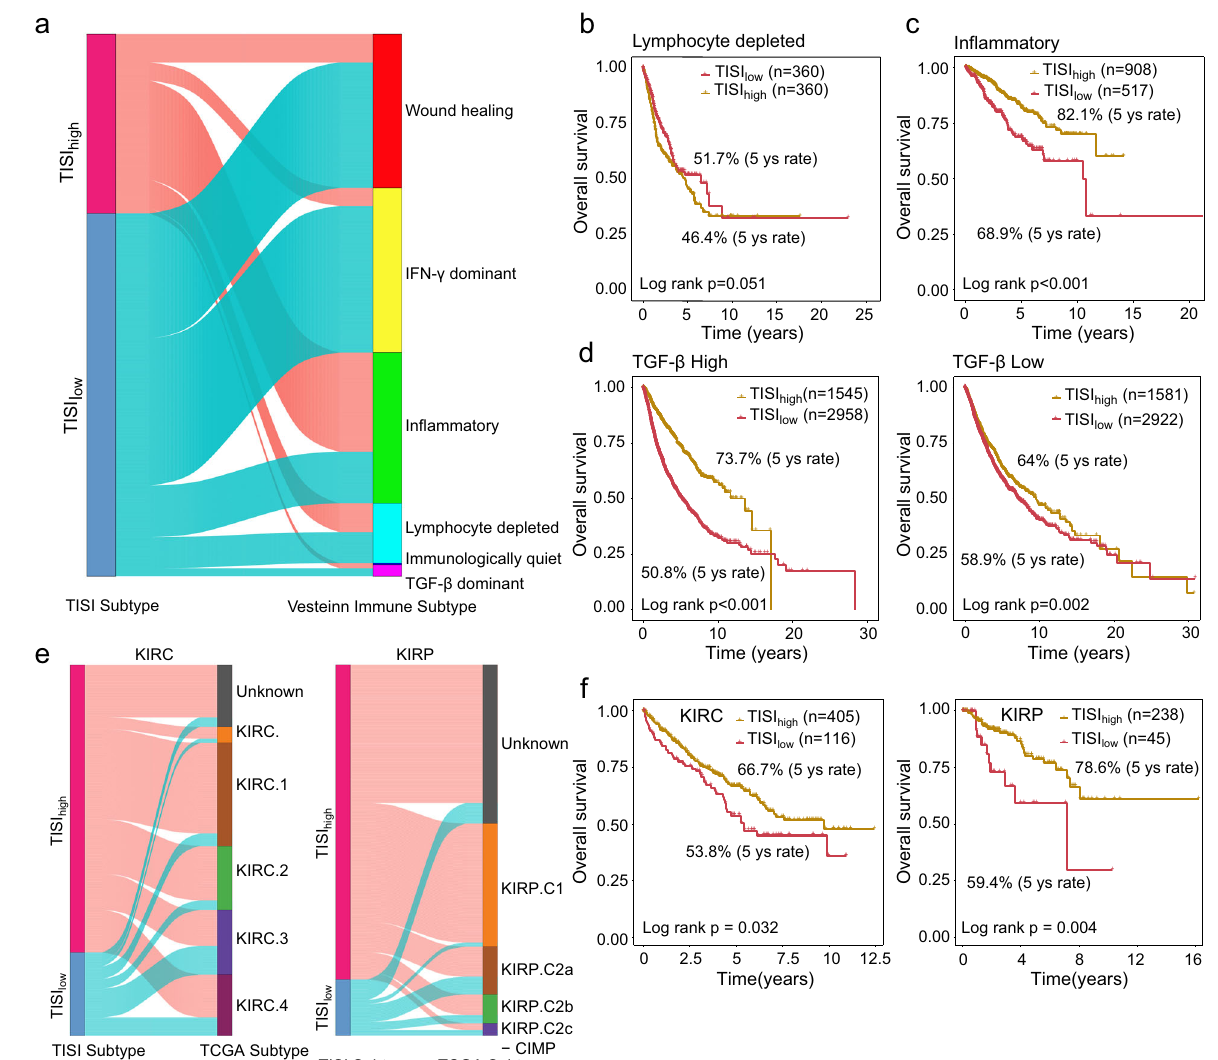
Fig. 4 Concordance between TISI-de fi ned risk groups and immunological and molecular subtypes. a Alluvial diagram showing the association between TISI-de fi ned risk groups and immunological subtypes. b – d Kaplan – Meier survival curves of tumor patients between the TISI high and TISI low groups in several immunological subtypes. The P -value was calculated by the log-rank test. e Alluvial diagram showing the association between TISI-de fi ned risk groups and molecular subtypes of KIRC and KIRP. f Kaplan – Meier survival curves of tumor patients in the TISI high and TISI low groups in KIRC and KIRP. The P -value was calculated by the log-rank test. TISI TIL-lncRNA-derived immune state index, KIRC kidney renal clear cell carcinoma, KIRP kidney renal papillary cell dominant ISs. Therefore, strati fi cation analysis of the TISI for C3- The TISI provides additional prognostic value for tumor immunological and molecular subtypes in fl ammatory, C4-lymphocyte depleted, and C6-TGF- β dominant ISs was conducted. Although the C3-in fl ammatory IS has been The correlation between TISI-de fi ned risk groups and immune reported to have the best prognosis, the TISI was still able to subtypes (ISs) de fi ned by immune signature sets was further investigated 29 . As shown in Fig. 4a, TISI-de fi ned risk groups were effectively identify a subgroup of patients at high risk for poor present in all ISs, but their relative distribution differed among ISs. prognosis from the C3-in fl ammatory IS (log-rank P < 0.001; Fig. 4c). The C1-wound healing, C2-interferon (IFN)- γ dominant and C6- Although tumors in the C4-lymphocyte depleted and C6-TGF- β transforming growth factor- β (TGF- β ) dominant ISs were particu- dominant ISs are known to have the least favorable outcome, the larly dominant in the low TISI group, whereas the high TISI group TISI revealed a good prognostic prediction ability and could was enriched in the C3-in fl ammatory and C5-immunologically effectively distinguish high- and low-risk patients for the same C4- quiet ISs. A relatively equal distribution for TISI-de fi ned risk groups lymphocyte depleted (log-rank P = 0.051) and C6-TGF- β dominant was observed in C4-lymphocyte depleted ISs, which was ISs (Fig. 4b and d). For patients with high and low TGF- β signaling, consistent with the fact that C4-lymphocyte depleted ISs include a high TISI was signi fi cantly associated with improved survival subtypes with mixed signatures, whose prognosis is dependent on compared with low TISI (log-rank P < 0.001 for high TGF- β immune contexts (Fig. 4a). Further observation indicated that signaling, and P = 0.002 for low TGF- β signaling; Fig. 4d). The some of the low TISI tumors also occurred in the C3-in fl ammatory opposite trend was observed in the C4-lymphocyte depleted IS, in ISs, with some high TISI tumors occurring in the C6-TGF- β